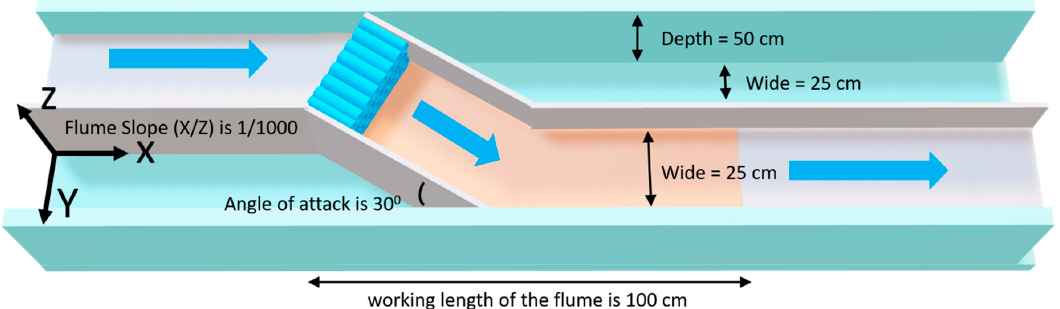
Figure 1. Sketch map of experimental channel (not to scale).